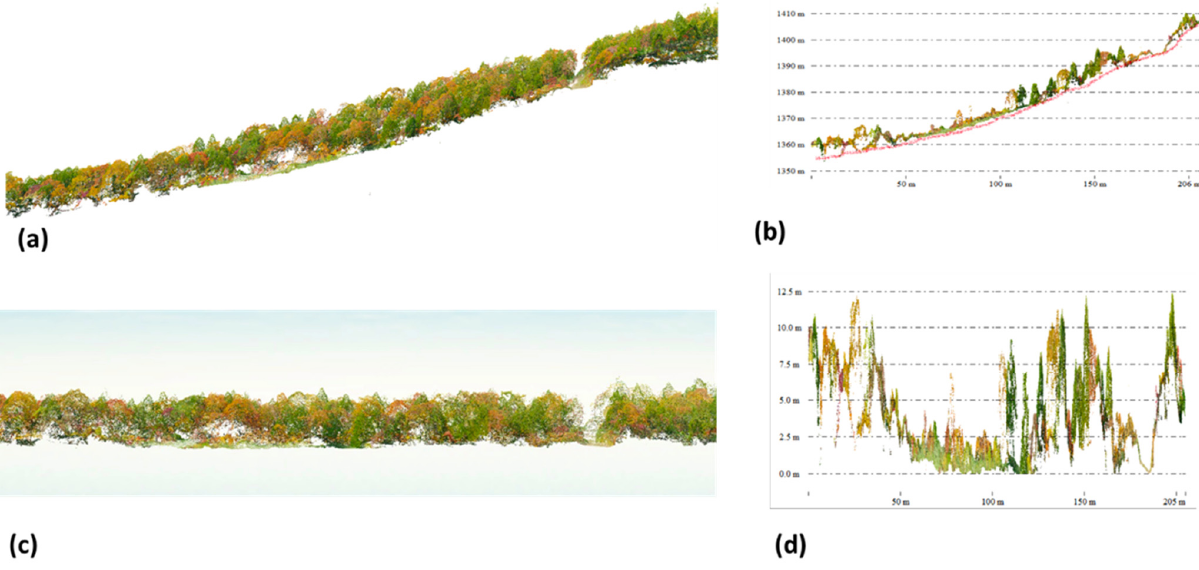
Figure 2. DPC normalization: ( a ) DPC; ( b ) filtered ground points based on a digital terrain model; ( c ) normalized points; ( d ) height above ground.